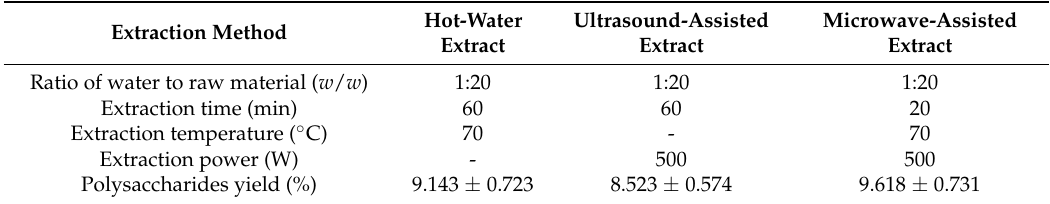
Table 1. Polysaccharide yield after following different extraction